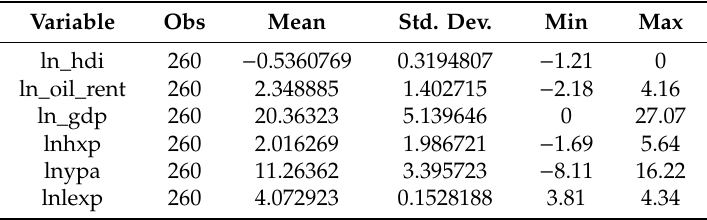
Table 5. Descriptive statistics of the observed